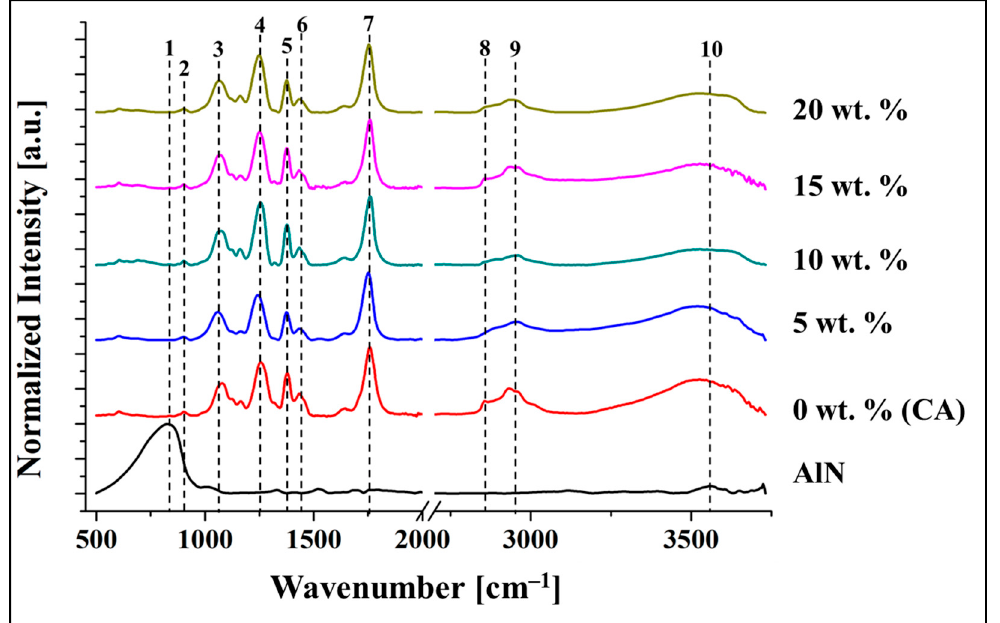
Figure 4. FTIR spectra of the CA/AlN composites.